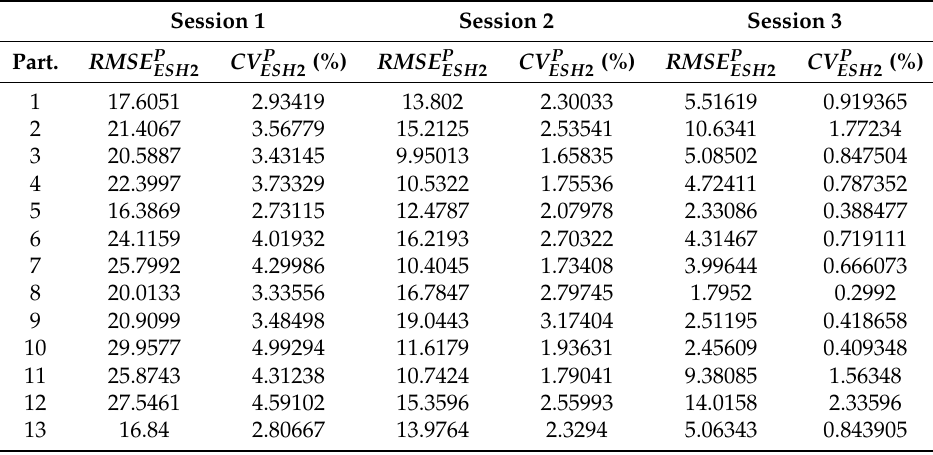
Table 9. Forecast errors of the exponential smoothing with quadratic H model ( ESH 2) for the three sessions. Session 1 Session 2 Session 3 Part. RMSE P ESH